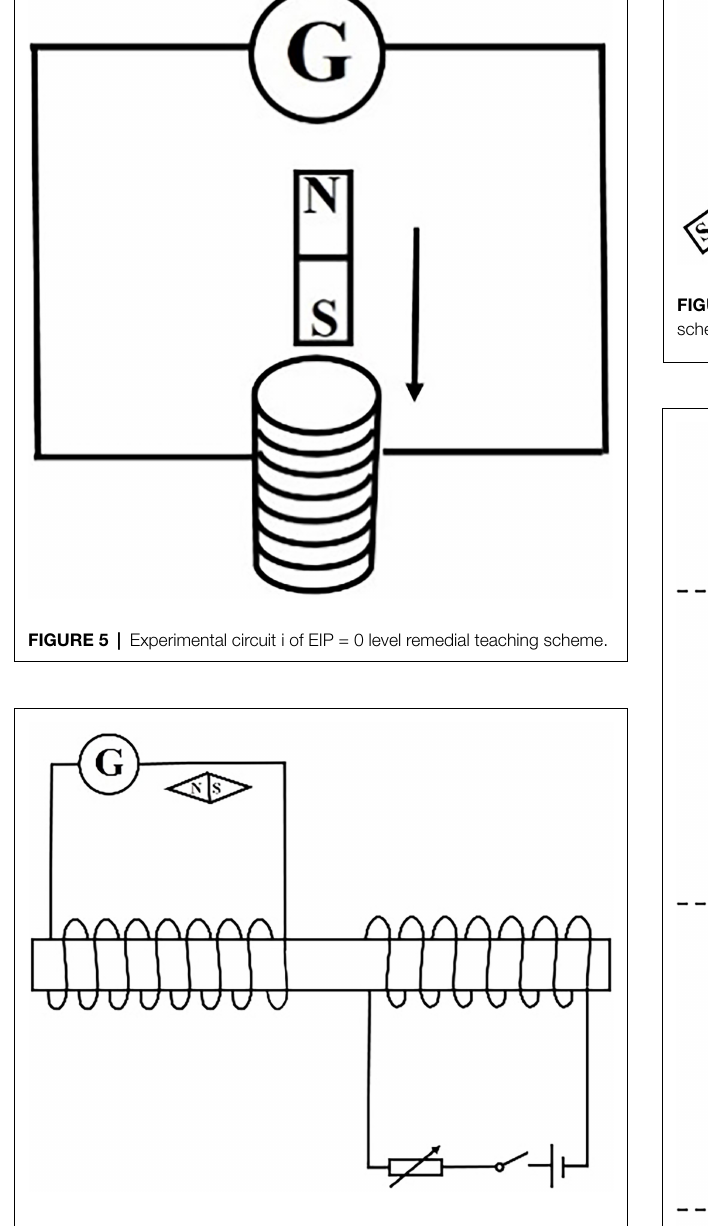
Table 2 : To clarify the relationship between work and energy in electromagnetic induction.